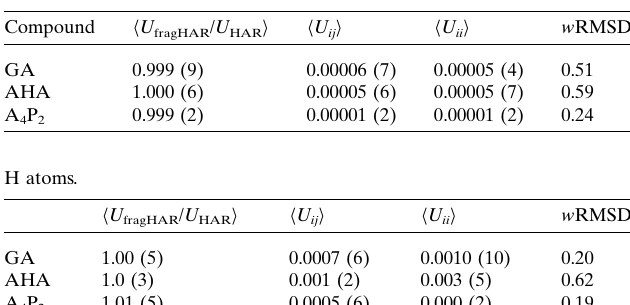
Table 3 Comparison of ADPs from fragHAR and HAR for non-H and H atoms. The diagonal and off-diagonal terms (three each) are treated separately. Values in parentheses represent the sample standard deviations. Non-H atoms.